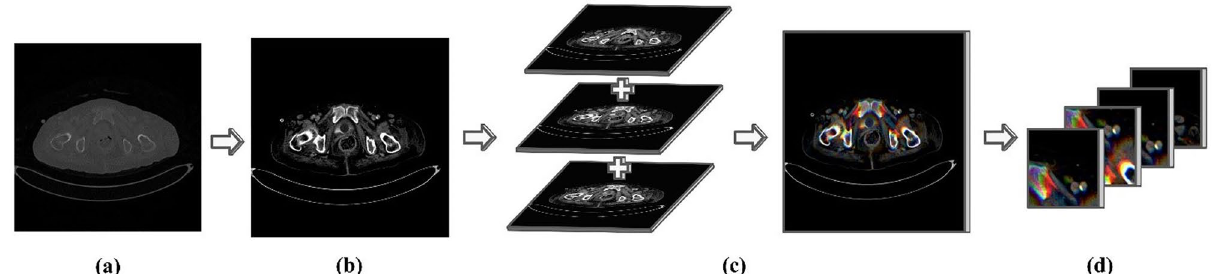
Figure 2. The process of generating synthesized three-slice data. ( a ) An original raw image; ( b ) An image- uniformed pixel spacing and set to a window width of 140 Hounsfield units (HU) and window level of 400 HU; ( c ) A synthesized image; and ( d ) A patch unit